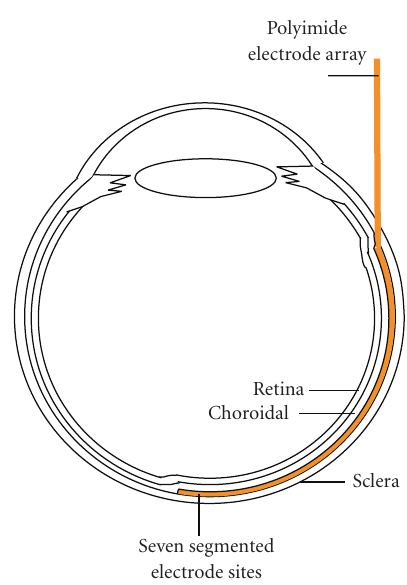
Figure 5: A diagram showing the positioning of an electrode ar- ray in the rabbit eye ball. The electrode array is colored in yellow. (Figure 9(a) shows a fundus photography of rabbit retina with a suprachoroidal